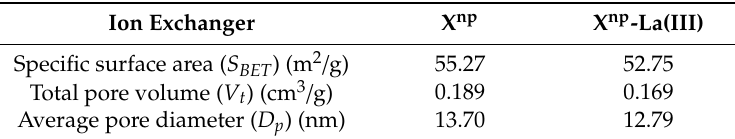
Table 2. Physical properties of X np and X np